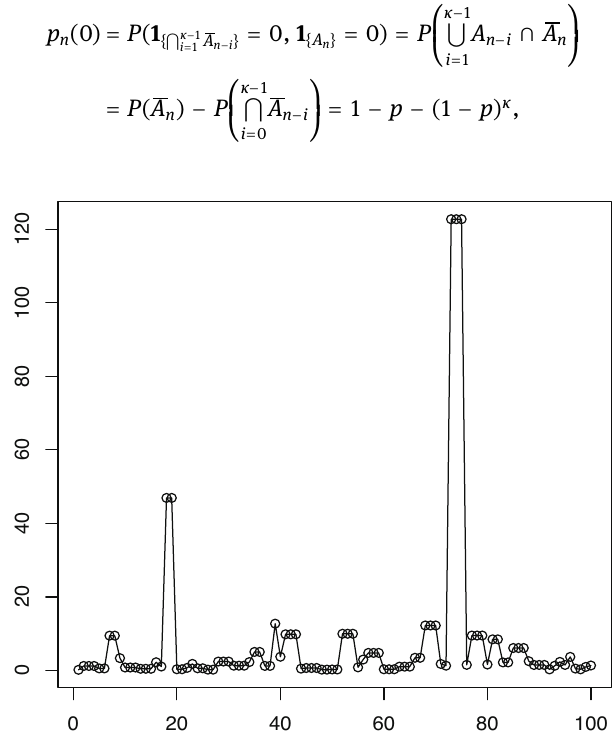
Figure 1: Sample path of 100 observations simulated from { } Y n de fi ned in ( 1 ) based on independent standard Fréchet { } X n and